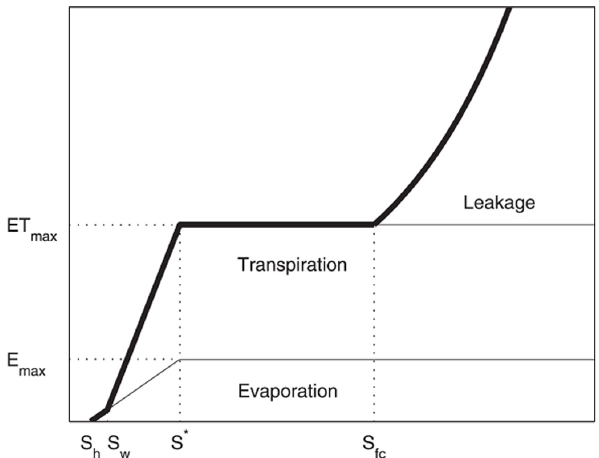
Fig. 2. Loss functions E(s) , T (s) , and L(s) as average degree of soil saturation, s , changes in the bucket model due to evaporation, transpiration, and leakage (redrawn from Guswa et al.,